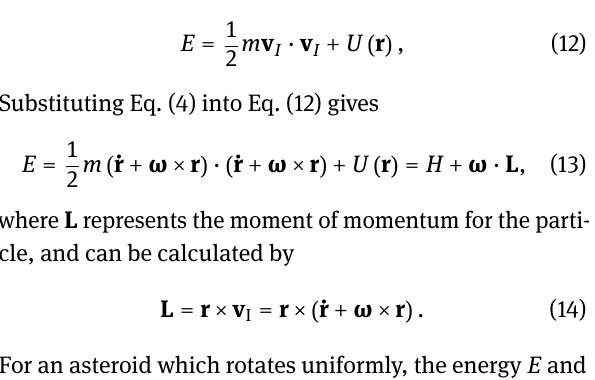
Jiang and Liu 2019; Jiang et al. 2016b,c; Zeng et al. 2016; Yang et al. 2018). The mass of the particle is too small rel- ative to the mass of the asteroid, thus we assume it is a massless